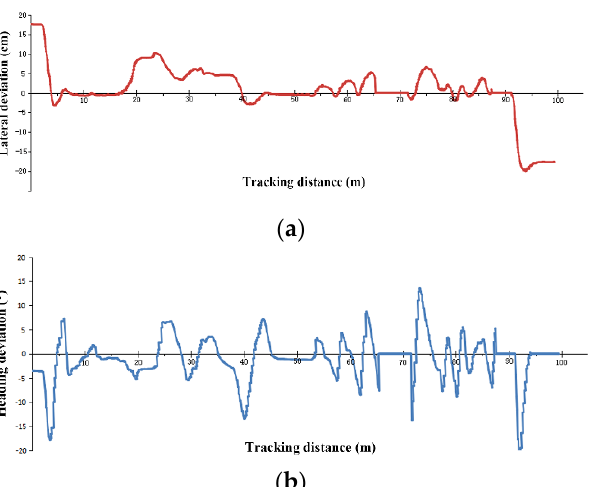
Figure 10. Path tracking error using traditional sliding mode. ( a ) Lateral deviation; ( b ) heading deviation.